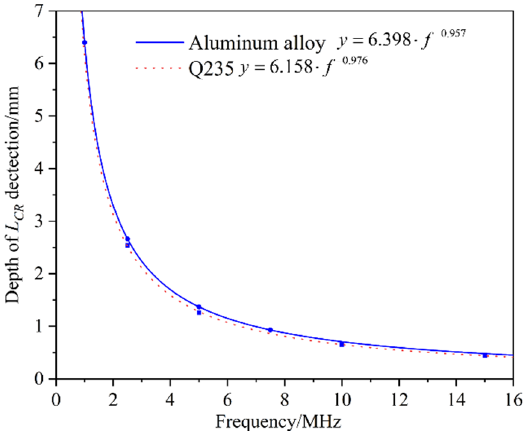
Figure 14. Relationship between the detection depth and the frequency of the L CR wave.